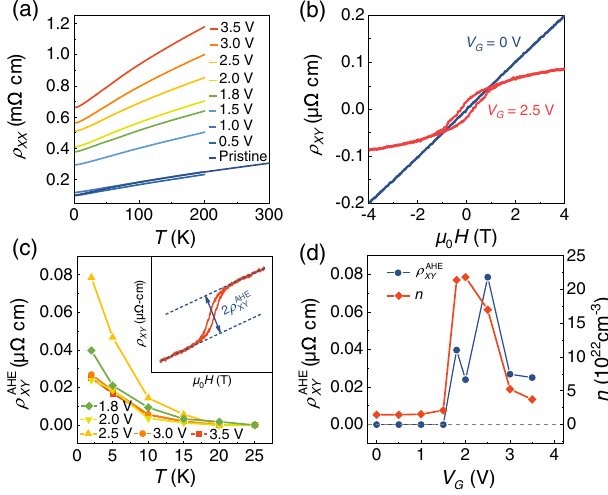
FIG. 2. Emergent ferromagnetism in proton intercalated CaRuO 3 thin films. (a) In situ temperature dependence of resistivity at different V . (b) Magnetic field dependent Hall G ¼ 2 . 5 V) states, resistivity at 2 K for pristine and gated ( V G respectively. (c) Temperature-dependent anomalous Hall resis- at different V . The inset illustrates the method to tivity ρ AHE G XY ¼ 2 . 0 V and from a representative Hall loop ( V obtain the ρ AHE G XY T ¼ 2 K). (d) Summary of ρ AHE and carrier density ( n , extracted XY from linear part of Hall signal at high-magnetic-field region) as a at 2 function of V G